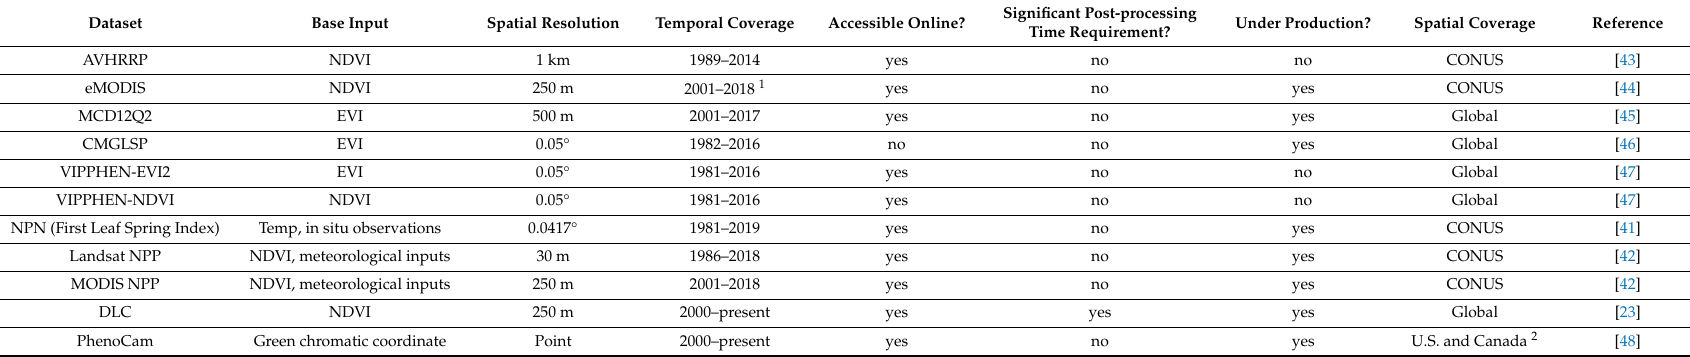
Table 1. Abridged data table summarizing the 10 freely available datasets evaluated against PhenoCam. See Table A1 and Equations (A1)–(A7) for more information including methods used to derive individual metrics and data acquisition